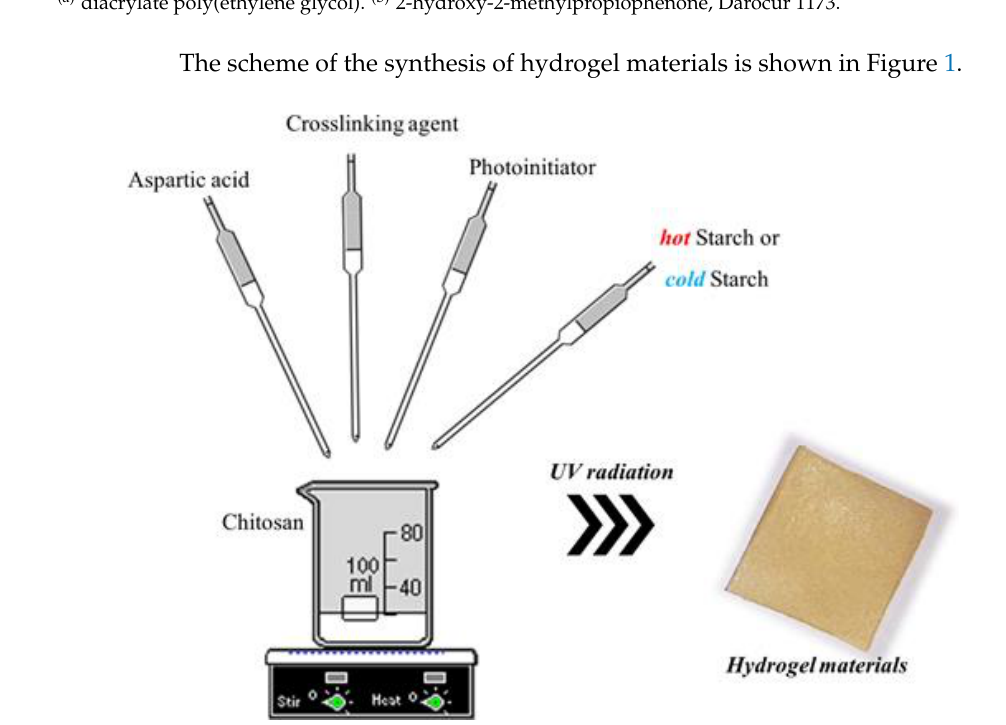
Figure 1. The scheme of the synthesis of hydrogels.